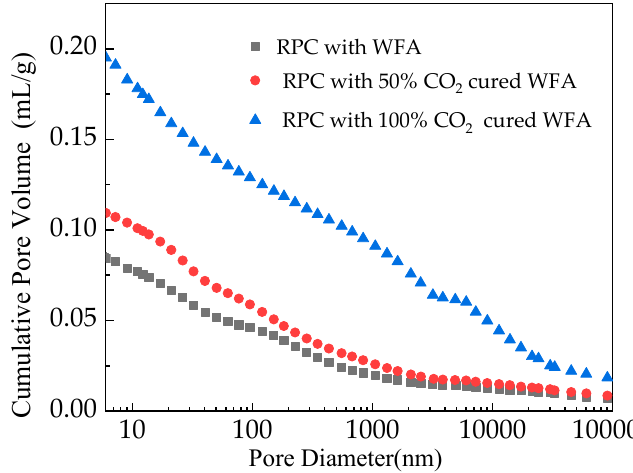
Figure 13. Relationship between pore size and mercury intake.